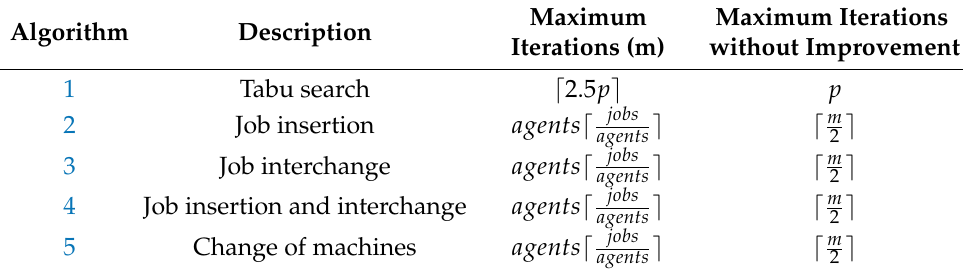
Table 1. Stopping criteria for the algorithms by number of